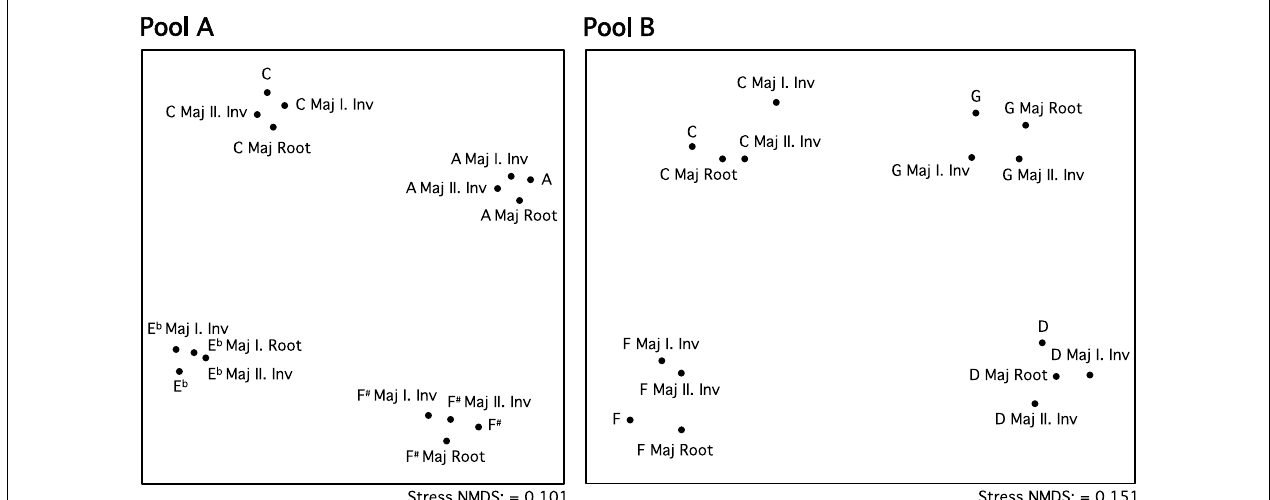
FIGURE 1 | “Expert maps PoolA and Pool B.” This figure depicts the mean expert representations of Pool A (left) and Pool B (right), computed by averaging the individual ( n = 13) NMDS maps (Oechslin et al., 2006) which are based on the same 240 similarity ratings (120 for each pool) as performed by musical novices (see Materials and Methods).These maps provide a basis for